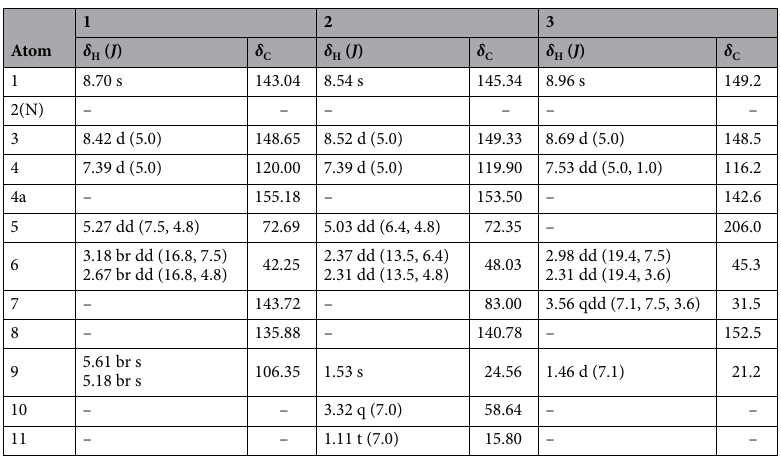
Table 1. 1 H and 13 C NMR data of the compounds 1 – 3 in CDCl 3 , ( δ in ppm, J in